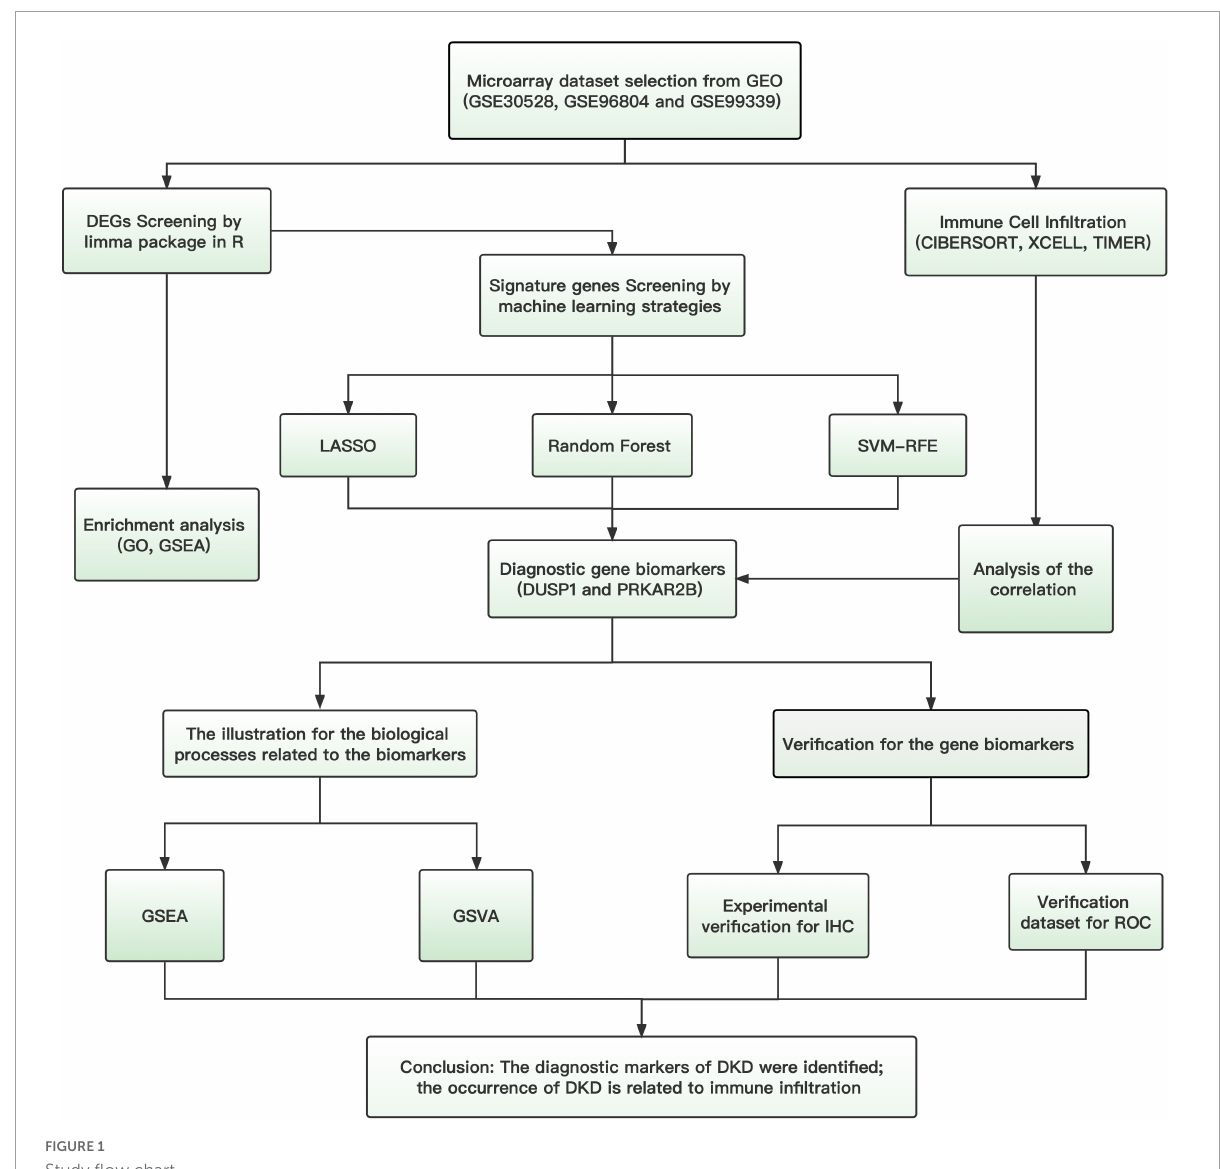
FIGURE1 Study flow